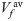
Diagram of optimal coefficient.
Vfav-dependence of the optimal coefficients: c¯2,c¯1,c¯0 is presented. A “parabolic” (or “linear”) zone implies that for a given Vfav, the optimal curve of Vf(r¯) satisfies c¯1=0 (c¯2=0).